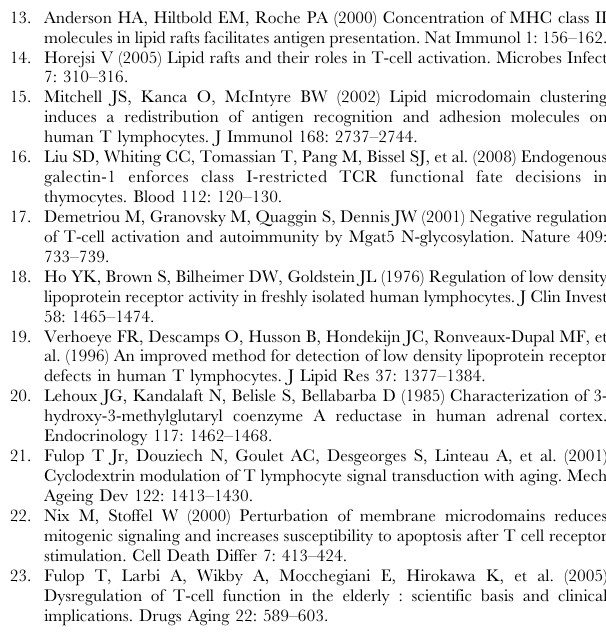
(TIF) Figure S3 Squalene enrichment of membrane choles- terol in unstimulated APCs alters their cytokine secre- tion. Unstimulated APCs from F1 mice untreated (dark bars) or squalene treated mice (180 m g/mouse) (light bars) were measured for IL-12, IL-6, and IL-1 a secretion in vitro, 7 days after squalene treatment (n= 5 mice/group). Cell culture supernatants from 2- day cultures of adherent lymphocytes harvested from individual spleens of each group of mice were measured by Luminex. Of note, only IL-12 secretion by unstimulated APCs from squalene treated mice was significantly increased (* p , 0.01). (TIF) Figure S4 Alteration in T-bet and GATA-3 mRNA expression levels in splenic cells enriched for membrane cholesterol and stimulated with CD3/CD28 Abs. Quan- titative real-time RT-PCR of T-bet and GATA-3 mRNA extracted from in vitro CD3/CD28-stimulated splenocytes from individual F1 mice treated i.p. or not with 1 dose of squalene (180 m g) (n =5 mice/group) was carried out 7 days after squalene injection. Y axis indicates the mean fold increase in mRNA expression level relative to the endogenous 18S rRNA expression level (control 6 SD). Shown are two combined separate experiments (* p value , 0.01).